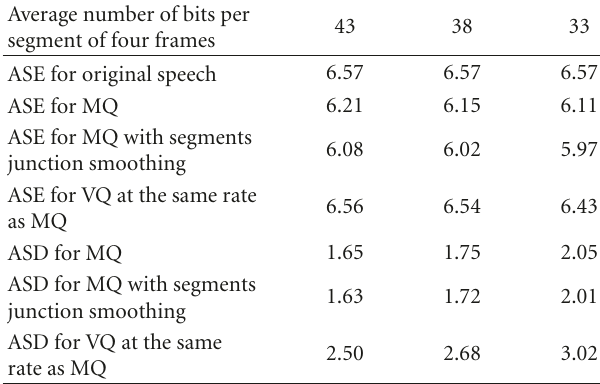
Table 4: Spectral dynamics and spectral distortion of matrix quantization versus vector quantization at the same